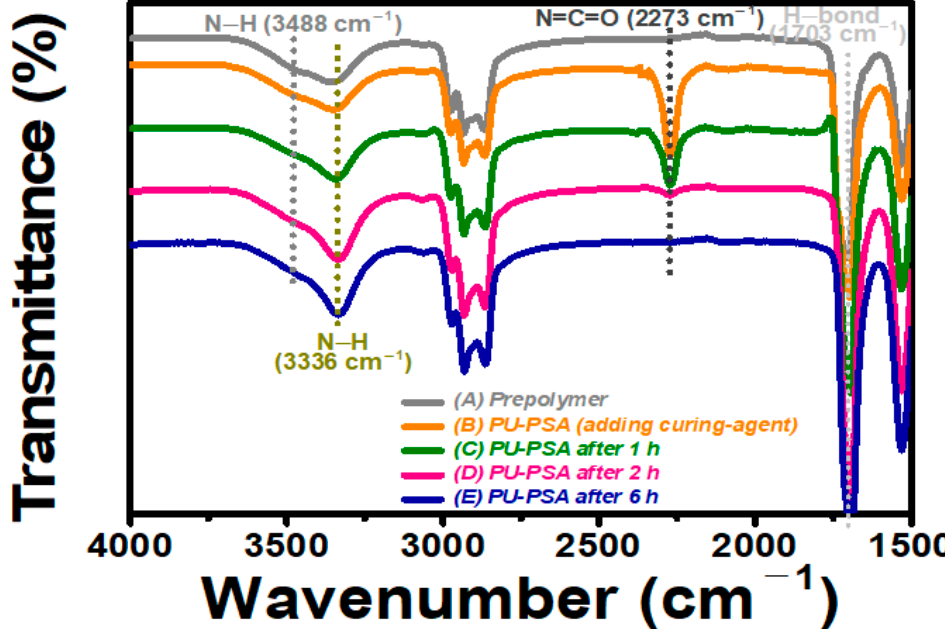
Figure 1. FT-IR spectra of PU-PSA synthesized by a two-step reaction.